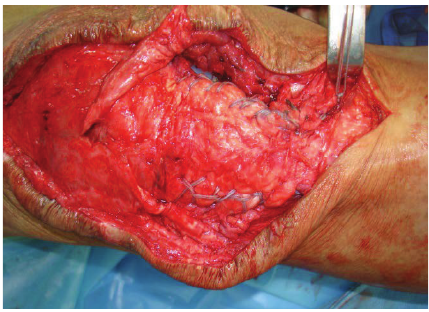
Figure 5: Showing sutures being passed through tunnel and tied.